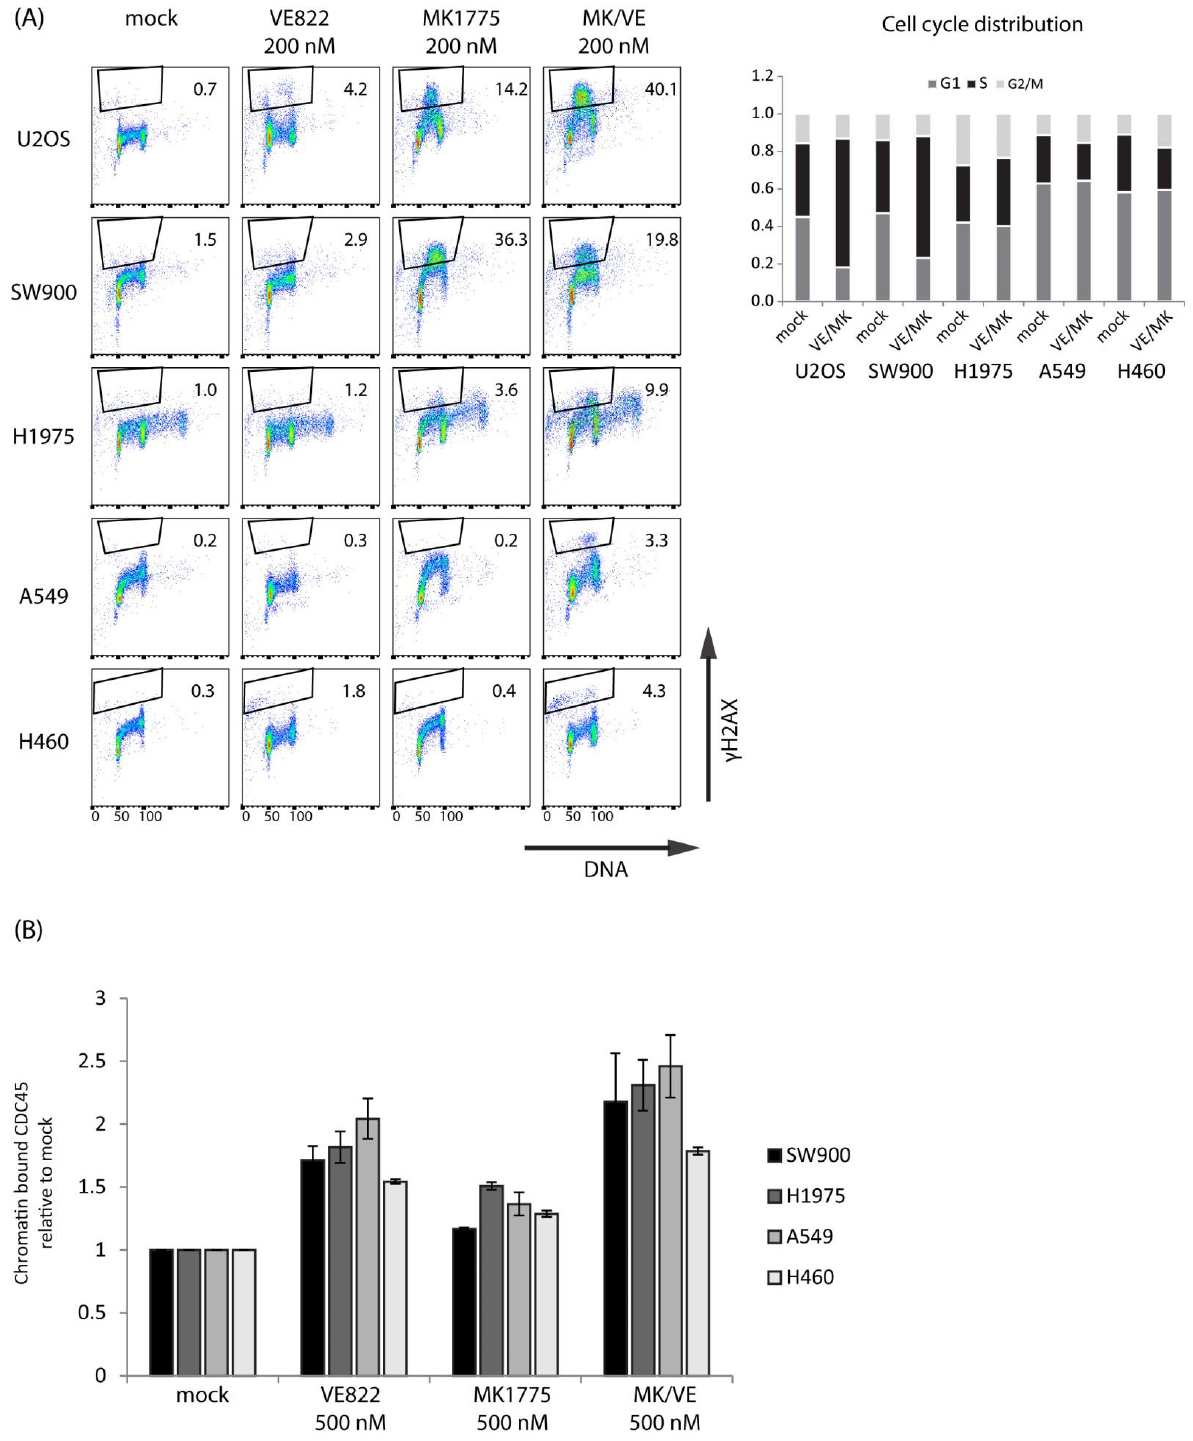
Figure 5. WEE1/ATR inhibition does not cause a large synergistic induction of γH2AX in lung cancer cells despite increased chromatin loading of CDC45. ( A ) Flow cytometry analysis of U2OS, SW900, H1975, A549, and H460 cells treated with MK1775 (200 nM) and/or VE822 (200 nM) for 24 h or left untreated (mock). Left: Scatter plots of γH2AX versus DNA content (Hoechst). Numbers indicate percentage of cells with strong γH2AX levels (within the marked regions). Results are representative of three similar independent experiments. Right: cell cycle analysis from mock and combination (MK/VE) samples showing the average fraction of cells in G1, S, and G2/M from three experiments. ( B ) Flow cytometry analysis of chromatin-bound CDC45 in lung cancer cell lines, treated as in Figure 1D and analyzed as in Figure